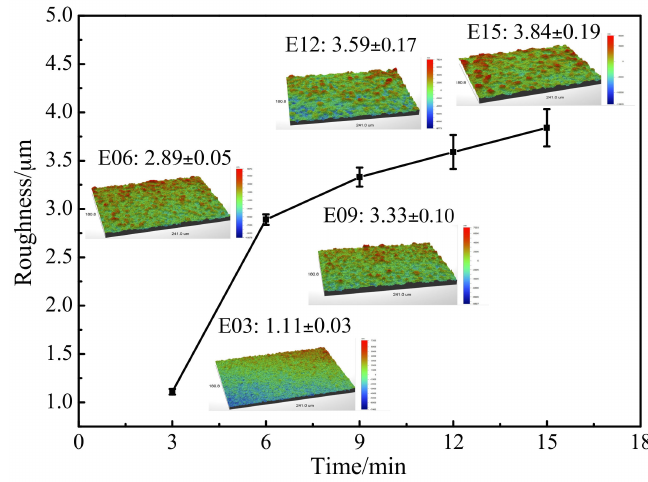
Figure 6. Roughness-time curve of MAO coating at different oxidation times. E03: 3 min; E06: 6 min; E09: 9 min; E12: 12 min; and E15: 15